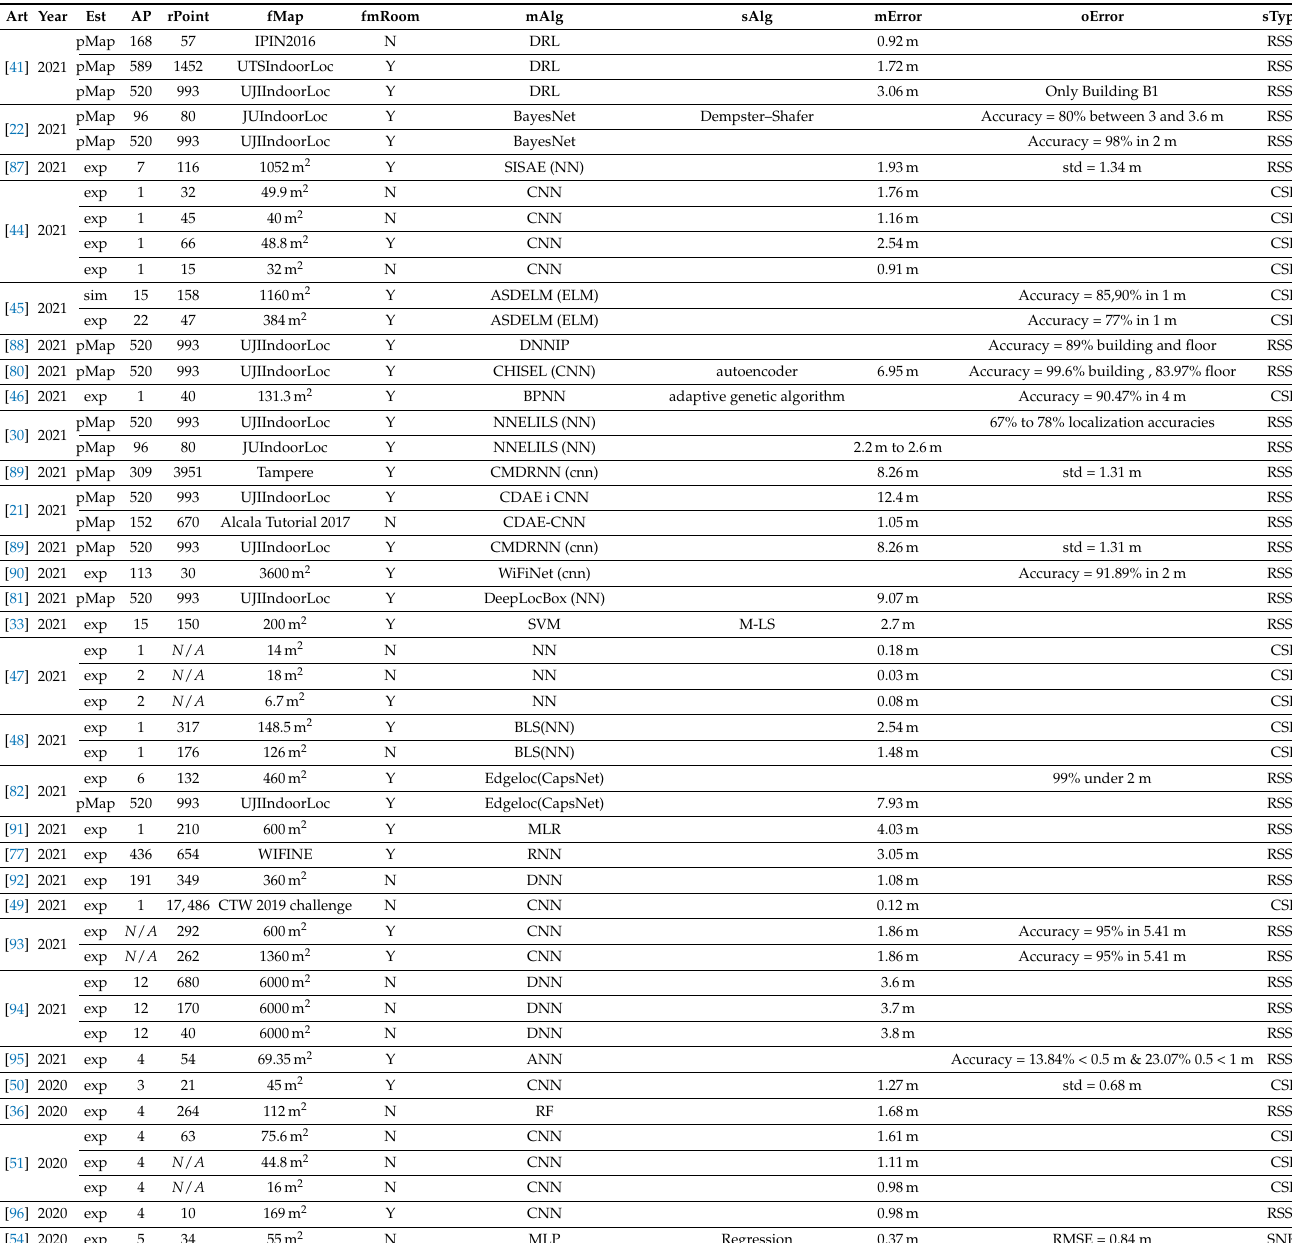
Table A1. Summary of reviewed